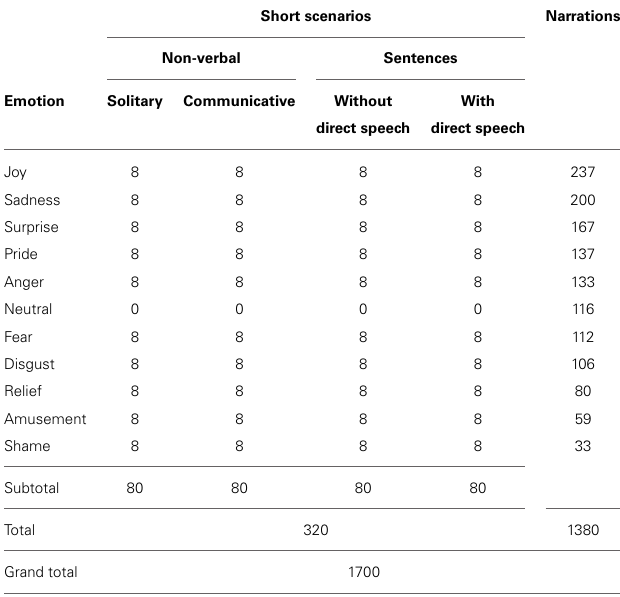
Table 1 | Count of motion sequences across emotion categories and acting